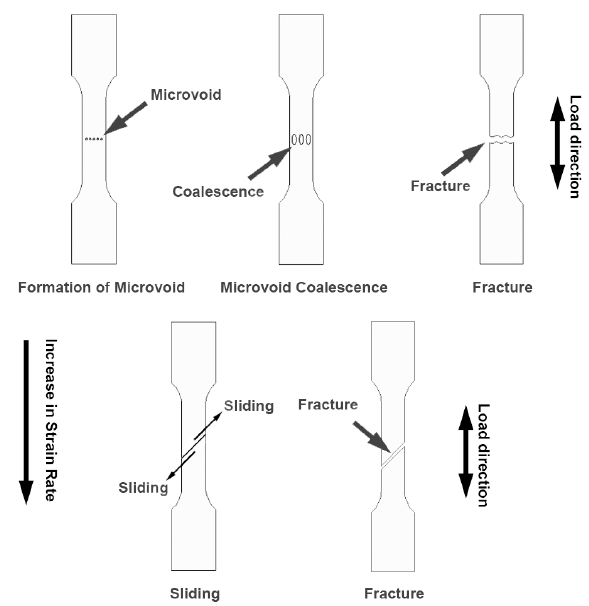
Figure 9. Schematic of the fracture mechanism for the thixoforged composite tensile tested at 200 °C under the low and high initial strain rates. under the low and high initial strain